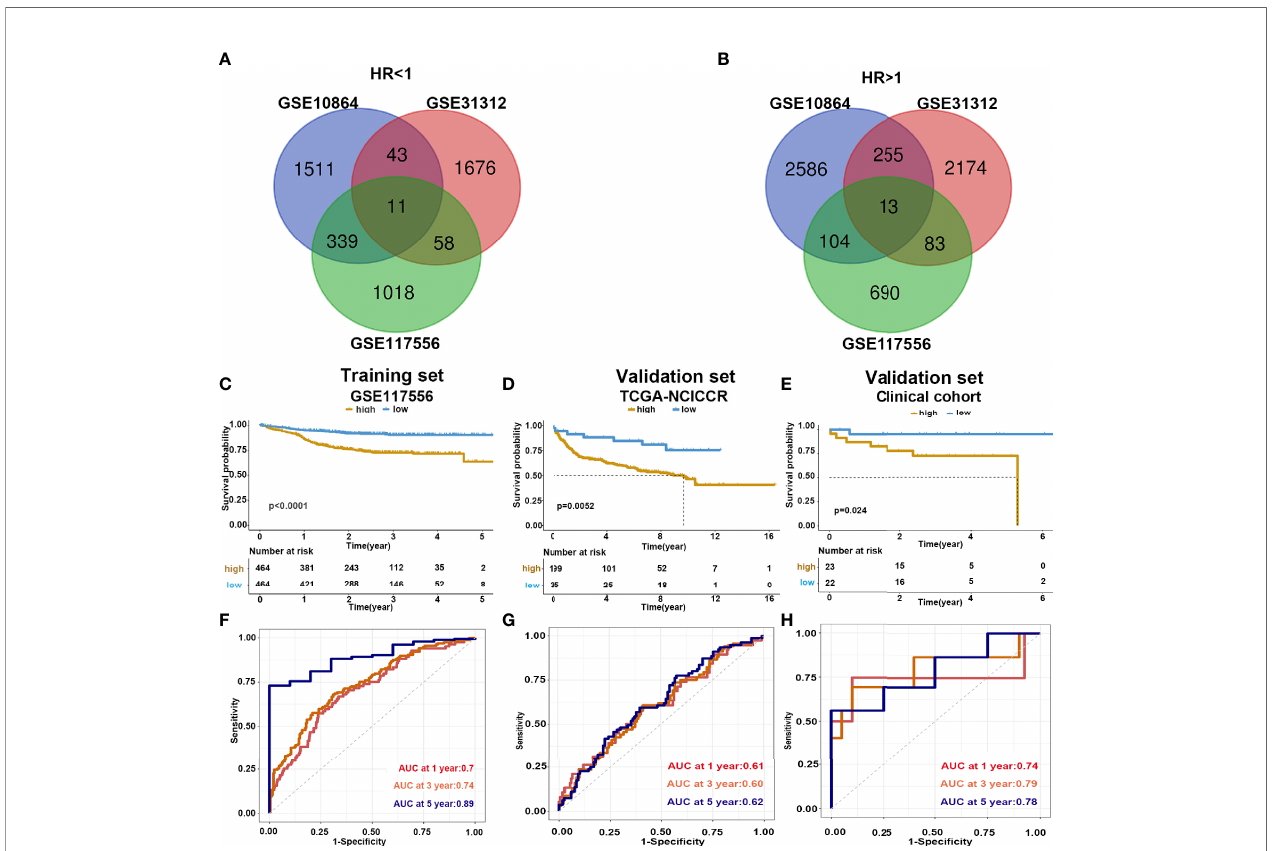
FIGURE 2 | Construction and validation of prediction model. (A, B) Venn diagram shows the common protective and risk genes identi fi ed by three datasets. (C – E) Kaplan – Meier analysis for the eight-gene signature in the GSE117556, TCGA-NCICCR, and our clinical cohort, respectively. (F – H) Time-dependent ROC curve analysis of 1, 3, and 5 years in GSE117556, TCGA-NCICCR, and our clinical